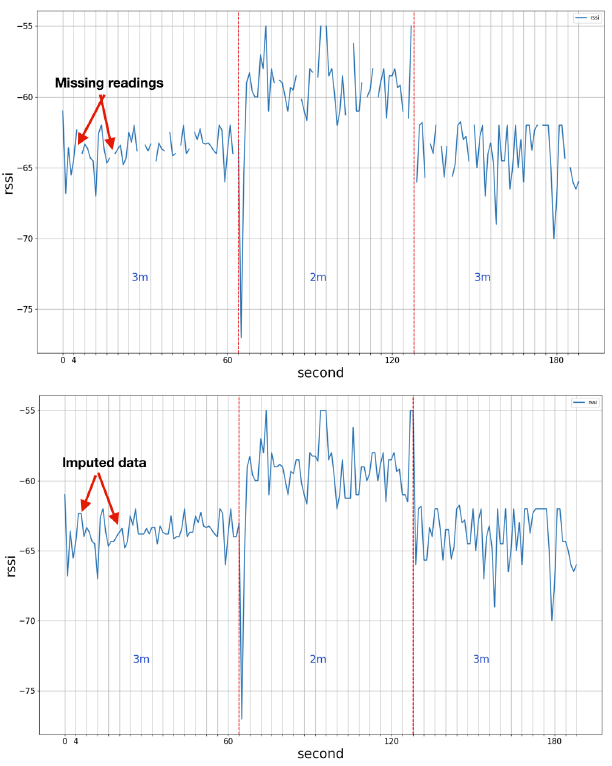
Figure 9. Rssi signal distribution with (top) and without (bottom) missing data